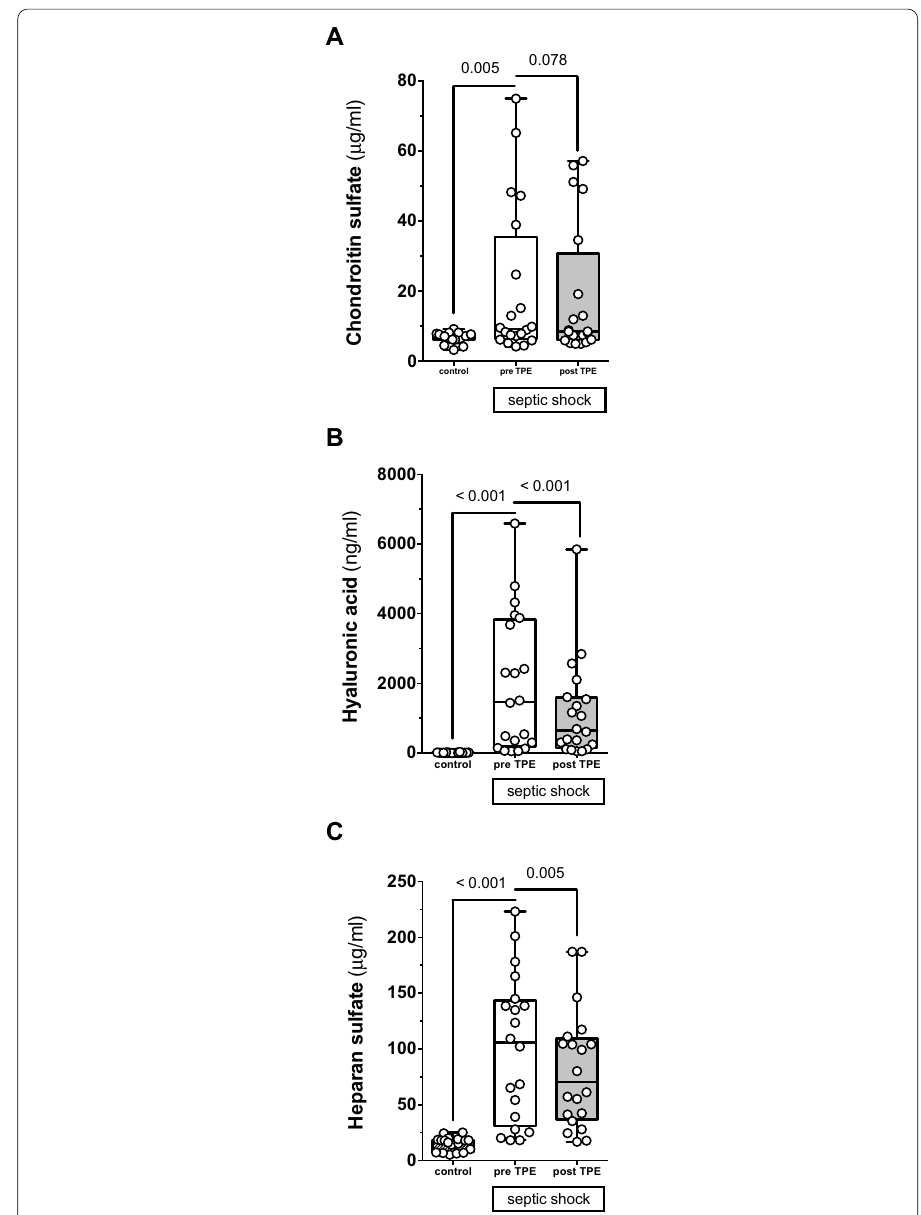
Fig. 3 Effect of therapeutic plasma exchange (TPE) on glycocalyx shedding products. Box and whisker plots showing blood concentrations of hyaluronic acid (HA) ( A ), chondroitin sulfate (CS) ( B ) and heparan sulfate (HS) ( C ) for healthy controls ( n 20) as well as patients with septic shock before (pre) ( n = after (post) ( n 20) =